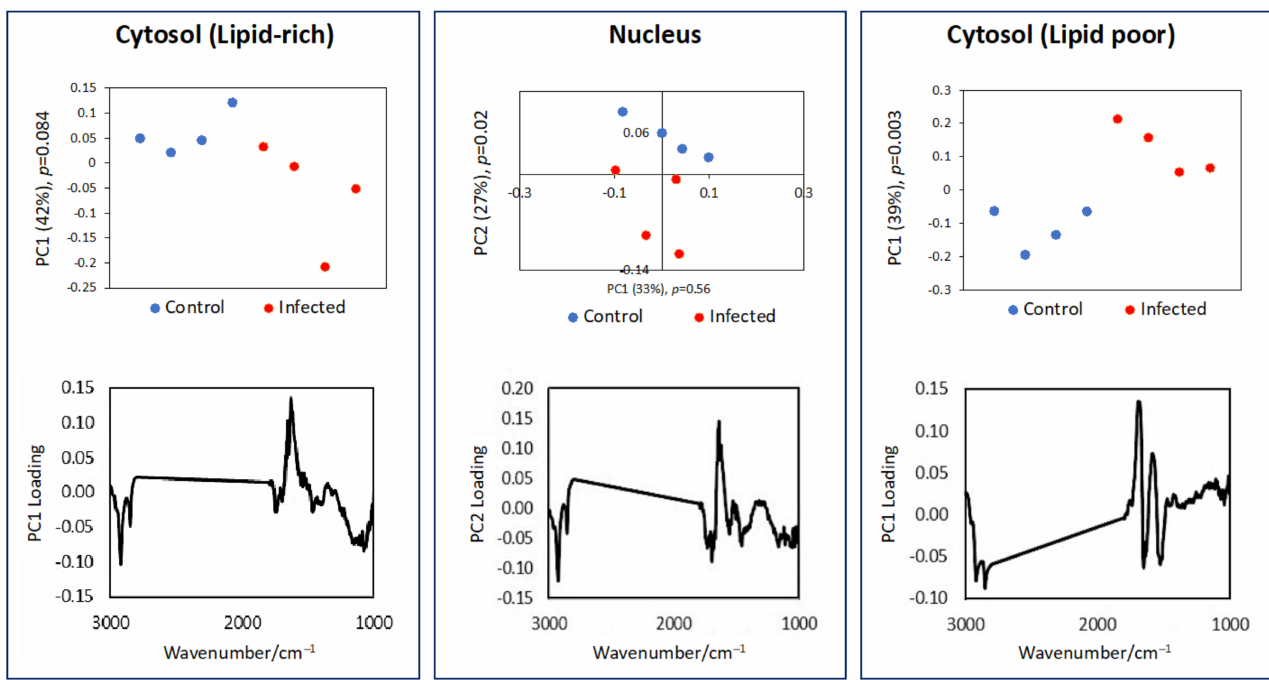
Figure 4. Pairwised (control versus infected) PCA of the extracted spectra (shown in Figure S5) from the three subcellular regions (cytosol (lipid-rich), nucleus, and cytosol (lipid poor)) with the most distinct differences between infected and uninfected cells at 24 hpi.